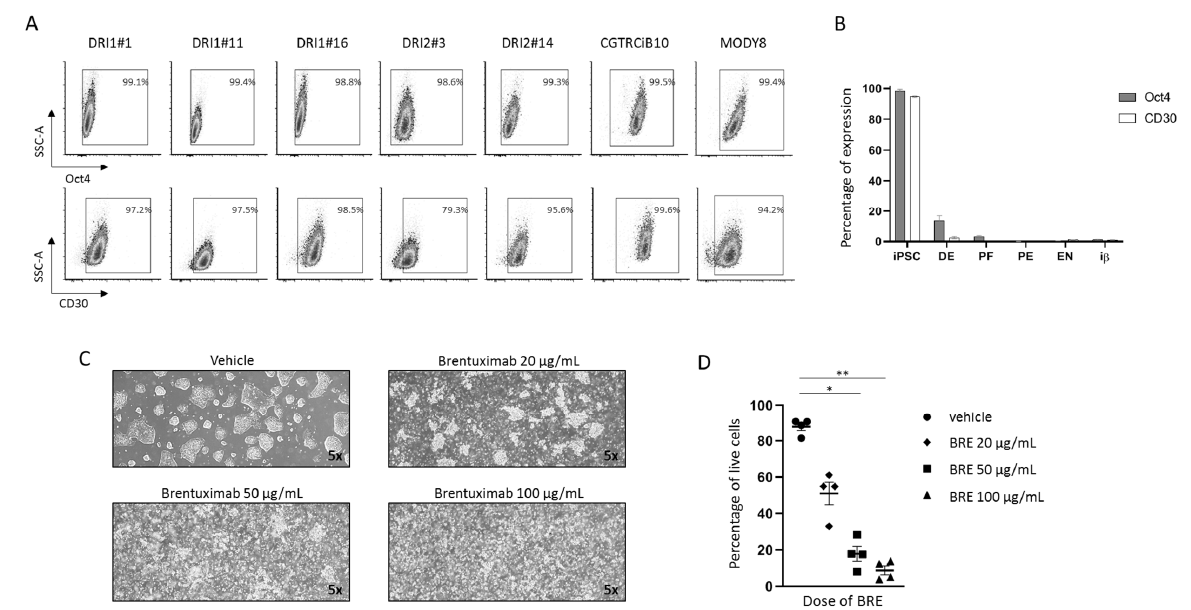
Figure 1. CD30 expression in iPSCs during differentiation into β cells and effect of brentuximab vedotin administration on undifferentiated iPSCs. ( A ). Representative plots of the percentage of cells positive for Oct4 (upper plots) and CD30 (lower plots) in flow cytometry in seven undifferentiated iPSC clones. Gate delimitates positive cells. ( B ). Histogram plot of the percentages of Oct4-and CD30-positive cells during the steps of differentiation (iPSC, DE, PF, PE, ENs and i β s) of MODY8 iPSC in four independent differentiation experiments. Results are expressed as mean ± SEM. ( C ). MODY8 iPSC morphology after 24 h treatment with vehicle or 20, 50, 100 µg/mL of BRE. Magnification 5×. ( D ). Percentage of MODY8 iPSC live cells in flow cytometry in the tested conditions. Each dot represents one experiment * = p < 0.05, ** = p <